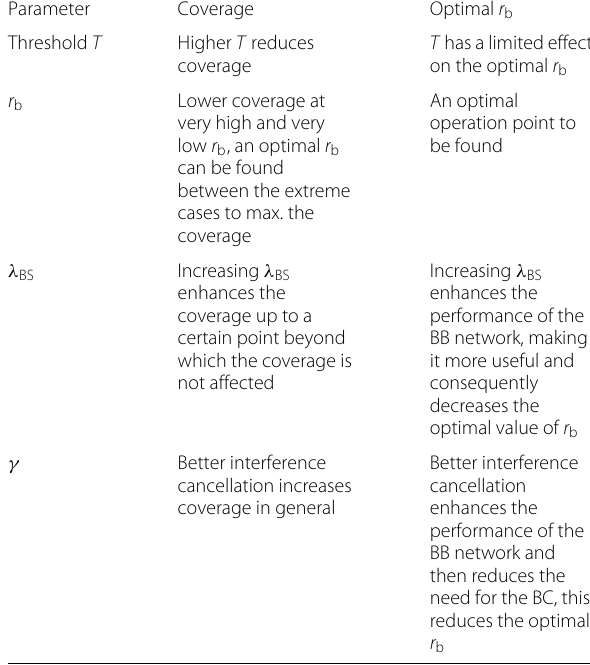
Table 3 Summary of the parameter effect